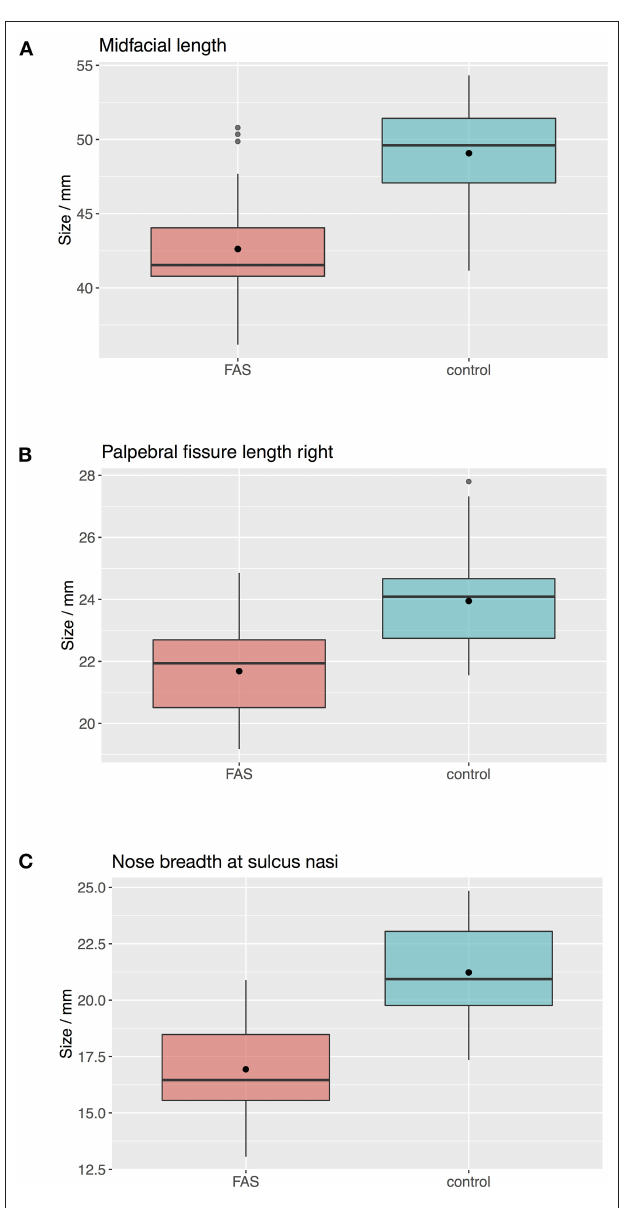
FIGURE 4 | Boxplots for facial landmarks. The boxplots for midfacial length (A) , right palpebral fissure length (B) and nose breadth at sulcus nasi (C) show significant differences between the values for the FAS and control group with lower results for patients with FAS. Nevertheless overlapping of all three parameters for patients with FAS and control group can be found.